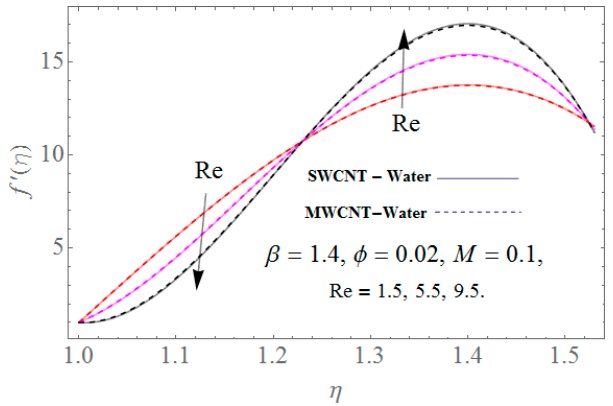
Figure 4. The impact of the Reynolds number versus the velocity field.